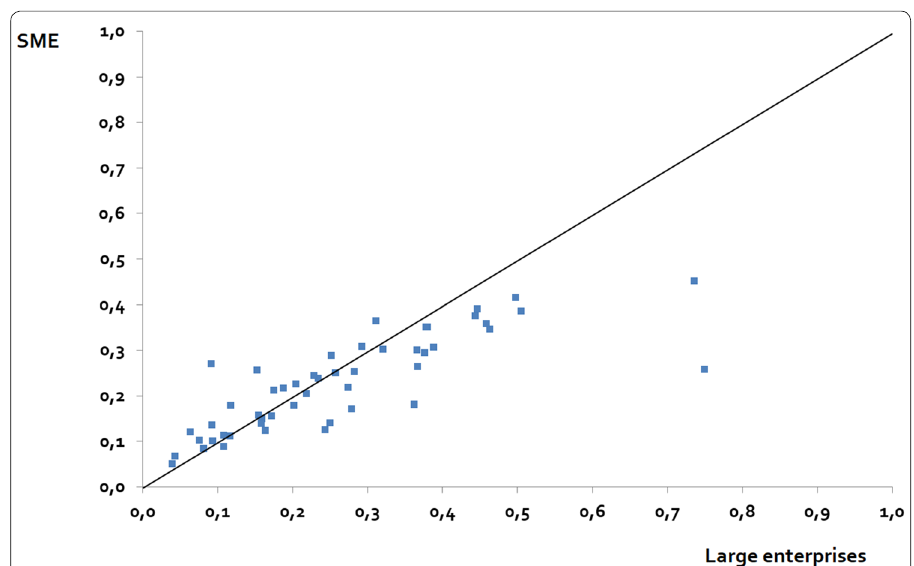
Fig. 2 Value of imports embodied in 1 euro of final production, by industry and size class,